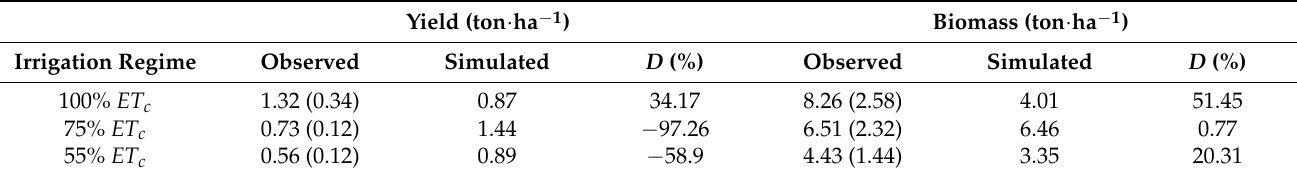
Table 8. Observed and simulated yield and final biomass during calibration.